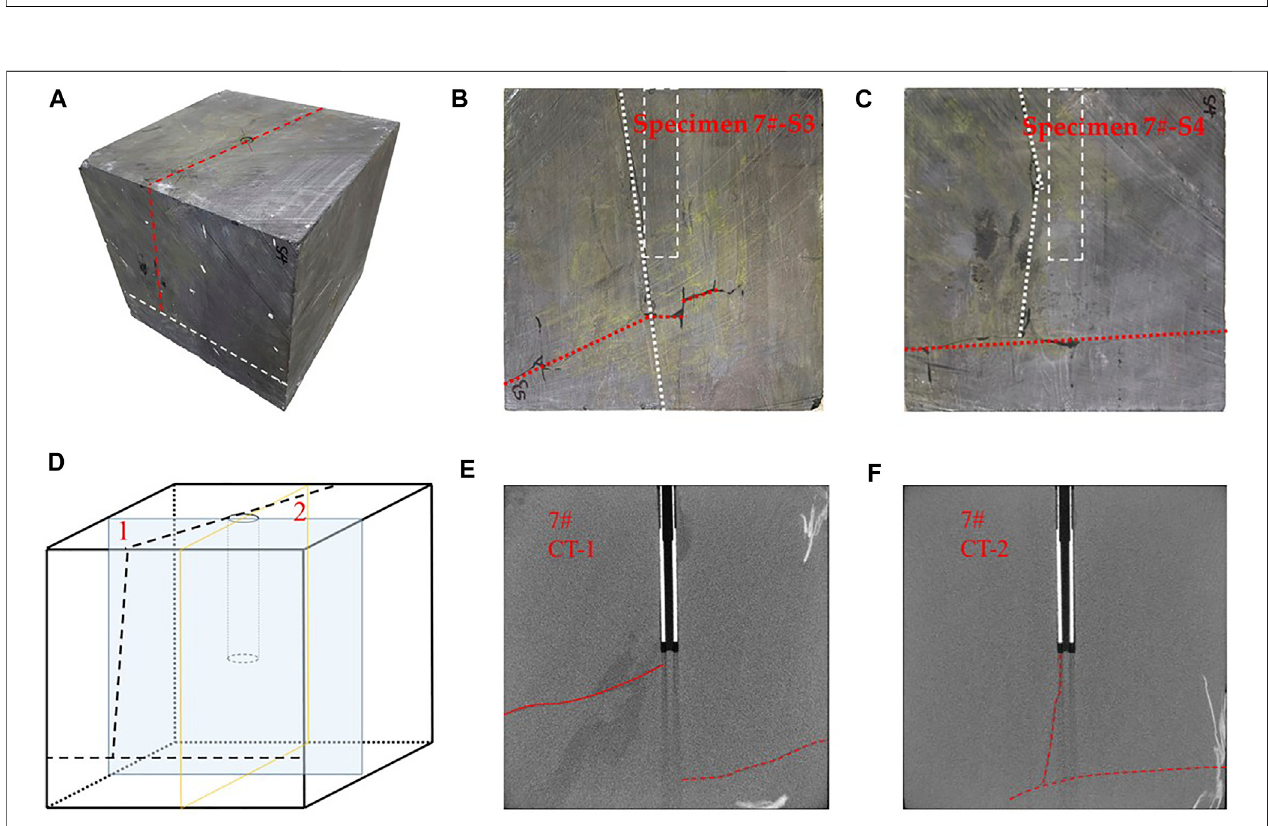
FIGURE7| Fracturemorphology created by supercritical CO 2 under high vertical stress: (A) Fracture morphology ofspecimen 7#; (B) S3surface ofspecimen 7#; (C) S4 surface of specimen 7#; (D) Scanning position of specimen 7#; (E) Scanning section 1 of specimen 7#; (F) Scanning section 2 of specimen 7#.